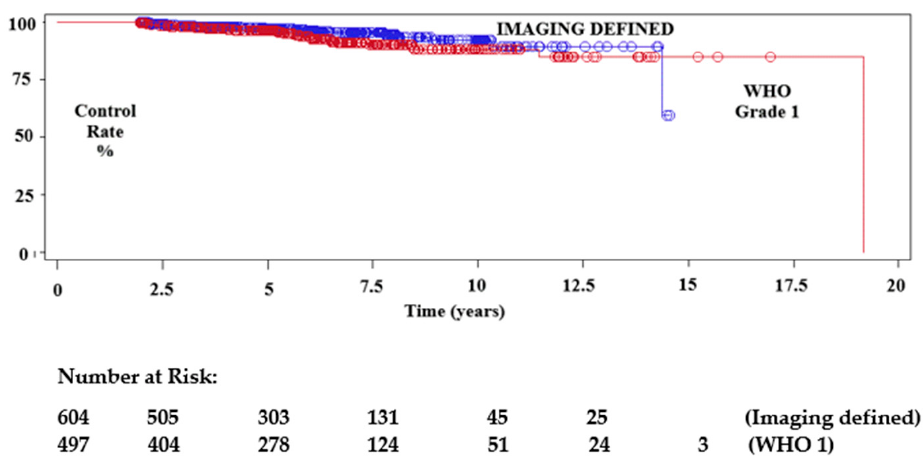
Figure 2. Kaplan–Meier test showing local imaging tumour control after SRS plotted by tumours without histological confirmation as well as histologically confirmed benign meningiomas (WHO Grade 1).